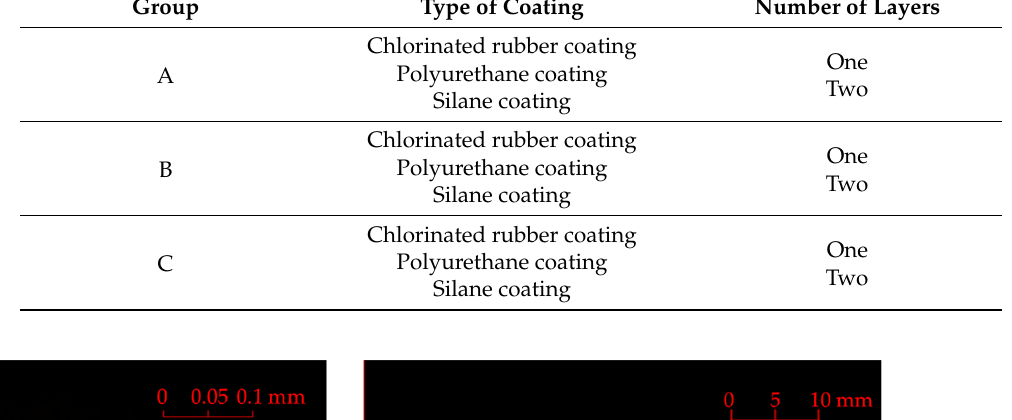
Table 5. Polymer coating types and layers used for the specimens.